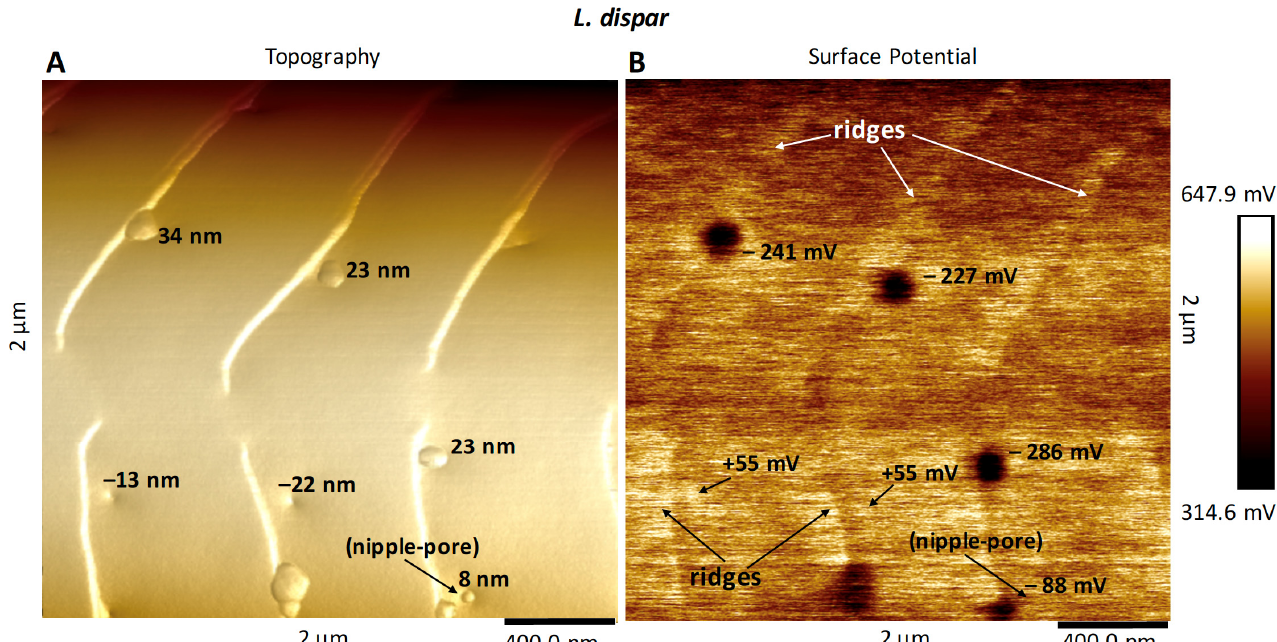
Figure 7. AFM surface potential readings from a 2 µ m × 2 µ m section of a Lymantria dispar trichoid sensillum related to height of domes, depth of open pores, and height of ridges. Note the mesh area of ridges in these images, incompletely crossing the surface of the sensillum. ( A ) Topography scan of the sensillum. Heights of domes and depths of pores are indicated on the figure. ( B ) Corresponding surface potential scan of this same section. Note the negative surface potentials of domes and positive surface potentials of pores. The ridges stand out as having more positive surface potentials than the flat planar inter-ridge regions.